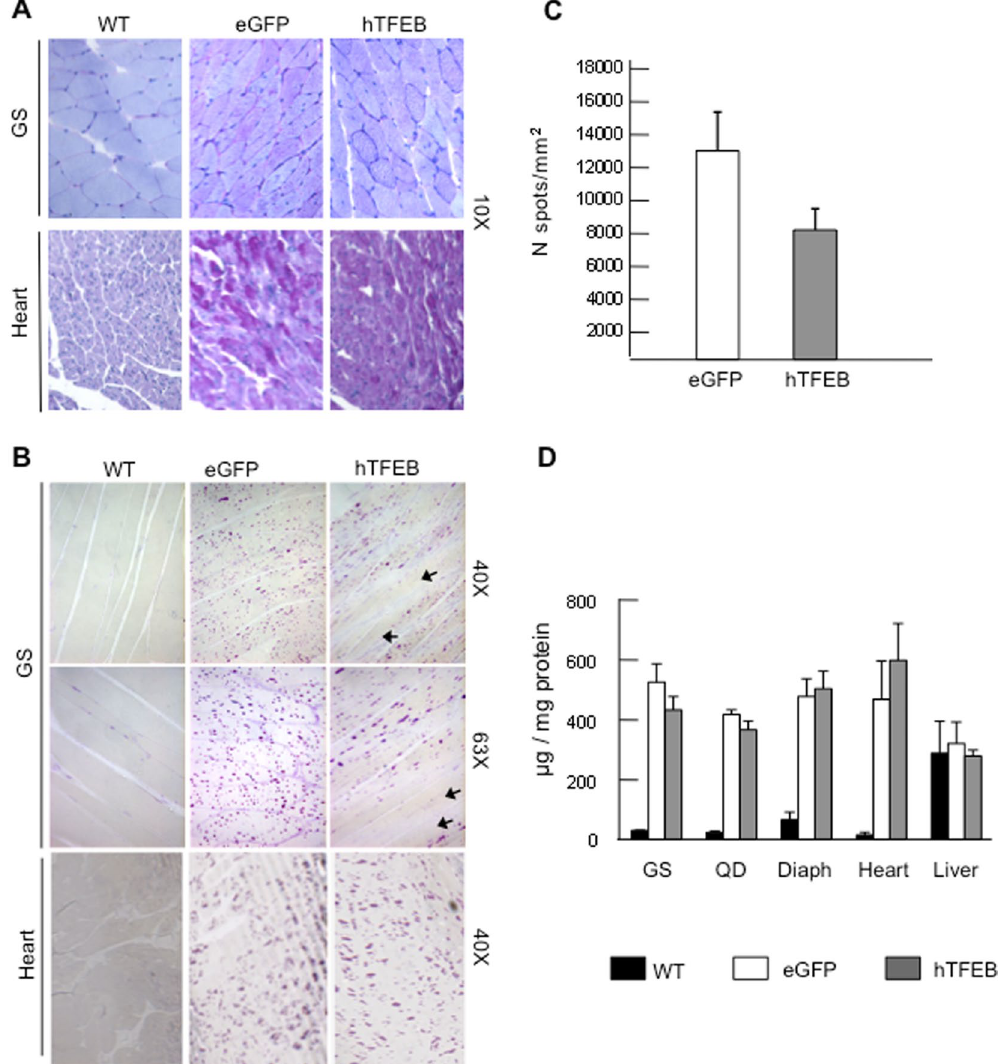
Figure 1. PAS staining in gastrocnemius and heart. PAS positivity has been evaluated in thick 8 µ m sections ( A ) from gastrocnemius and heart in 3-mo old mice. In both tissues, knock out eGFP-treated animals showed an increased signal dispersed throughout the cytosol of the fibers compared to wild type (WT) mice; TFEB treatment did not result in significant changes in the staining pattern. Original magnification: 20X. In thinner sections, 1 µ m, ( B ) PAS-positive glycogen-filled lysosomes were easily detectable both in gastrocnemius and heart. In TFEB-treated muscles individual fibers (indicated by arrows) showed very few PAS-positive spots. Original magnification: 63X. Scans of Pas stained whole muscle sections form two eGFP-treated and two TFEB- treated knock out animals were acquired using a Hamamatsu Scanner and analyzed by Visiopharm Image analysis software (VIS version 2017.5). The analysis showed decreased density of Pas-positive spots in TFEB- treated animals ( C ). Glycogen content ( D ) was evaluated in gastrocnemius (GS), quadriceps (QD), diaphragm (Diaph), heart and liver of wild type (WT), Pompe eGFP-treated and TFEB-treated 3-mo old mice. The one-tail Student’s t test was performed and no statistically significant differences between the two